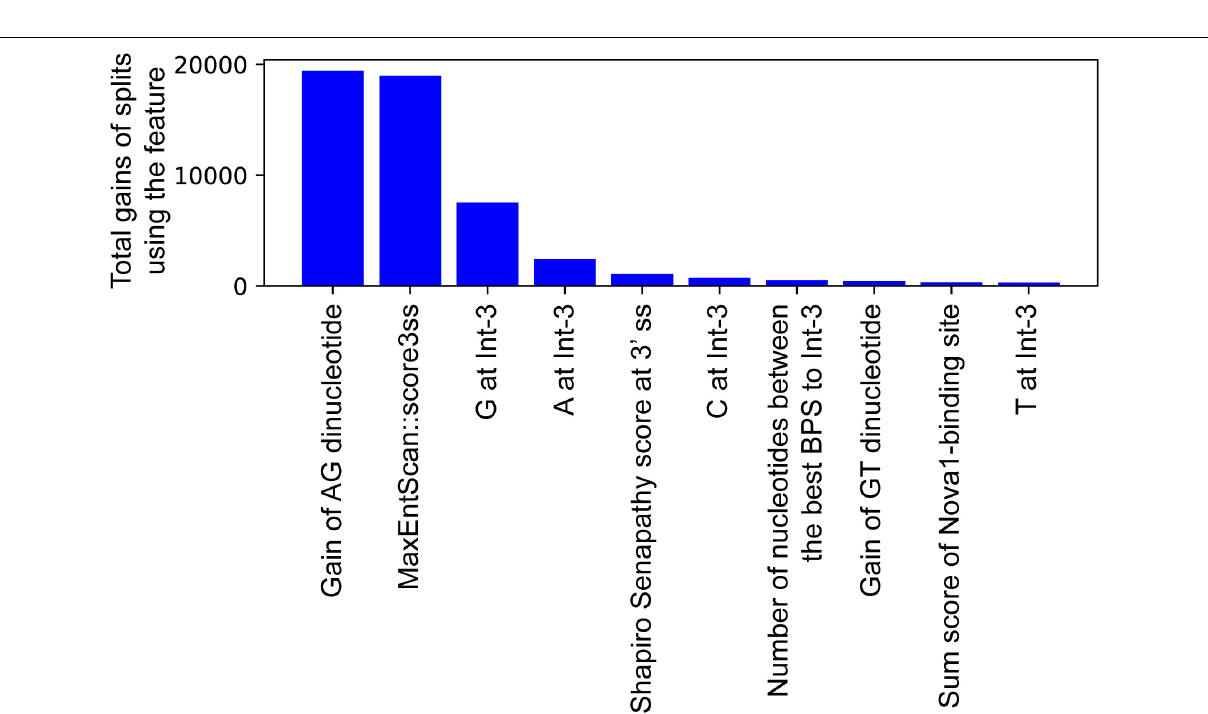
FIGURE 1 | Evaluation of IntSplice2 by fivefold CV. (A) Five iterated and mean ROC curves with AUROCs. (B) Five iterated and mean PR curves with AUPRs.